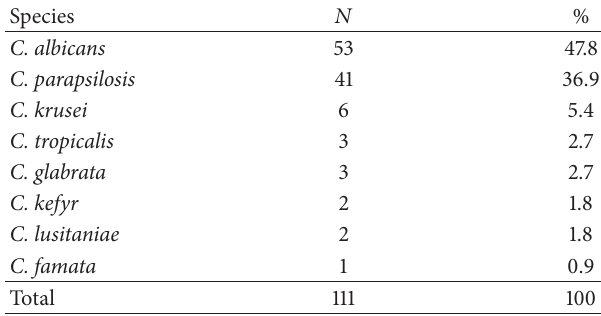
Table 1: Distribution of Candida species isolated from blood